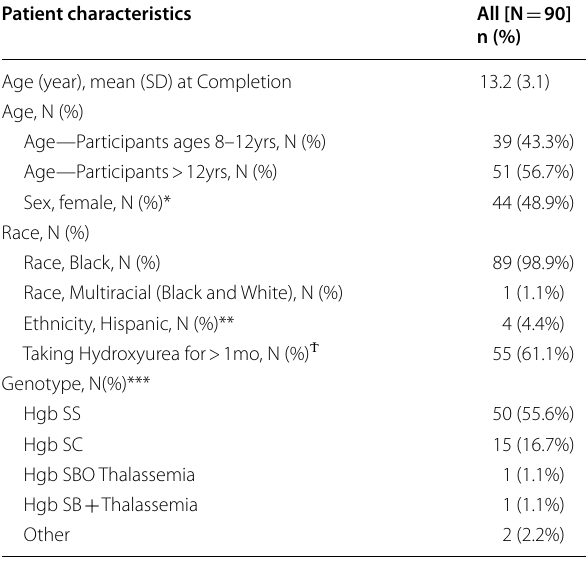
Table 1 Demographic and clinical characteristics of